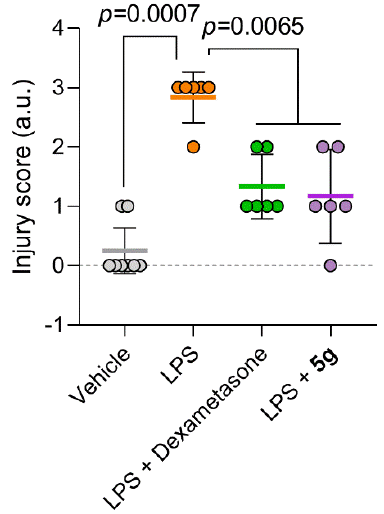
Figure 10. Histologic scoring of pulmonary inflammation. Data are shown as mean and 95% C.I.; statistical significance is calculated with the Mann–Whitney test.